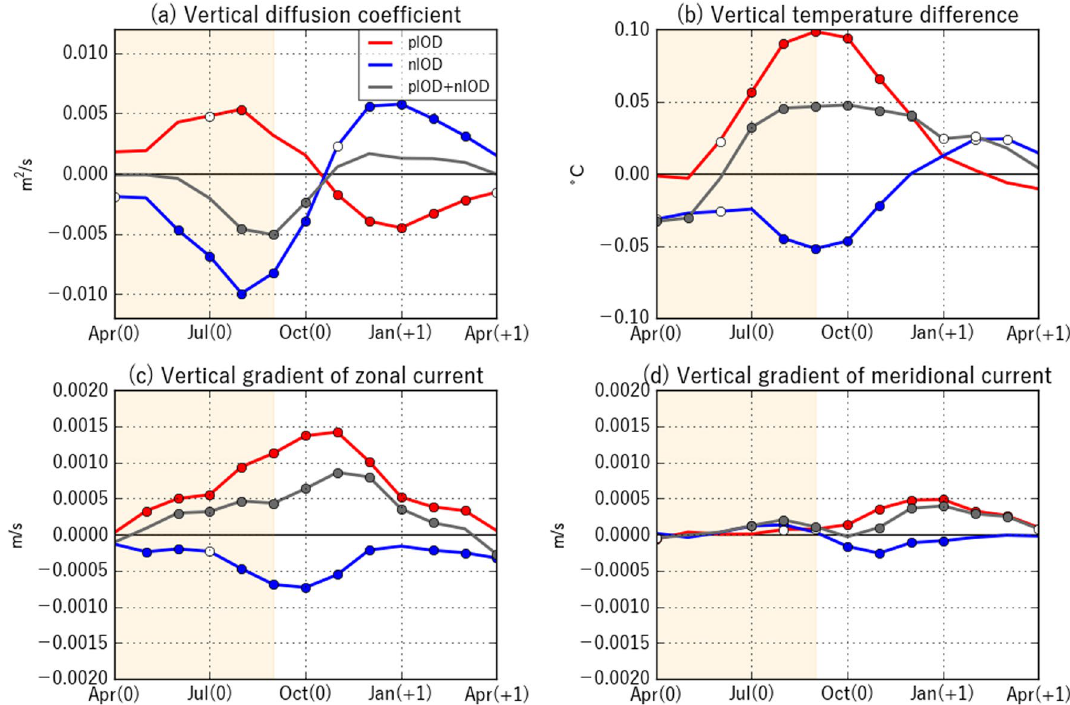
Figure 6. Vertical diffusion coefficients during pIOD and nIOD years. As in Fig. 4, but for ( a ) vertical diffusion coefficient (in m 2 /s), ( b ) vertical temperature difference (in °C), and vertical gradient of ( c ) zonal and ( d ) meridional current (in m/s) anomalies.